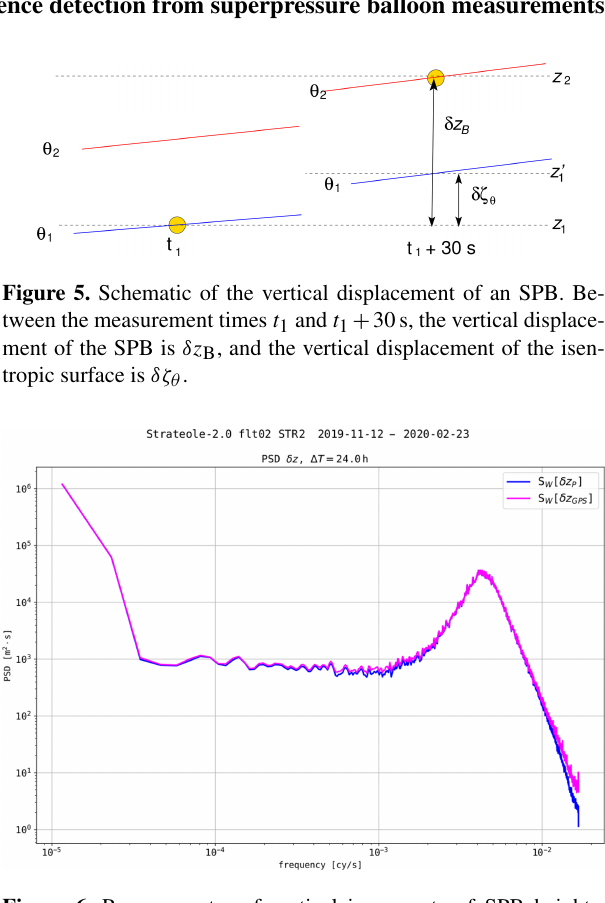
Figure 6. Power spectra of vertical increments of SPB heights, i.e., of vertical displacements between consecutive measurements (30s), for flight